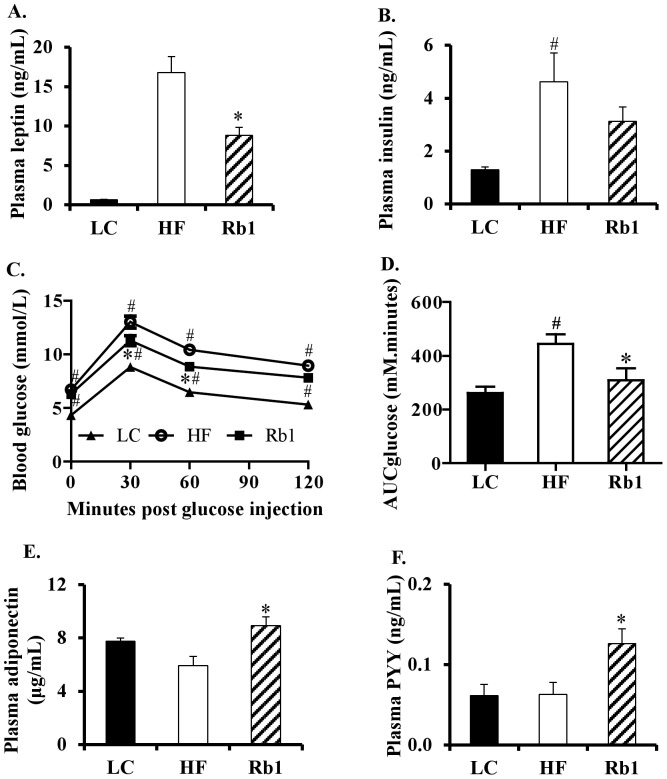
Chronic administration of Rb1 improved plasma profiles and glucose tolerance in obese mice fed a HF diet for 16 weeks.Rb1 decreased plasma leptin (A) and insulin (B), improved glucose tolerance (C) and AUC (D), and increased adiponectin (E) and PYY (F) in obese mice (n = 8) fed a HF diet for 16 weeks. *p<0.05 vs. HF control group; #
p<0.05 vs. LC diet control group. Data are presented as mean ± SEM. Area under the curve for glucose (AUCglucose) was calculated using the trapezoidal rule.